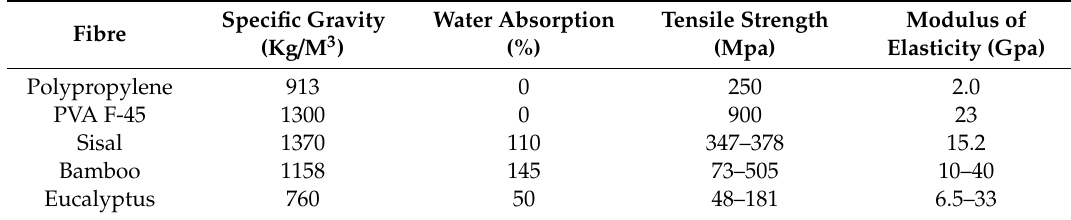
Table 2. The comparison of mechanical properties of several natural and artificial fibres